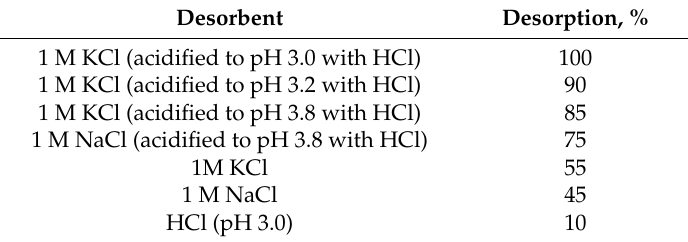
Table 2. Desorption efficiency of Pr(III) from